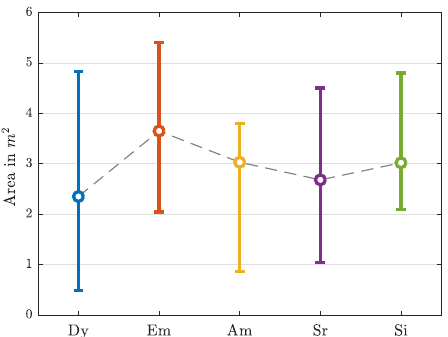
Figure 8. Median value and 95% confidence interval of the area under the standard deviation ellipse pooled for all beam directions ϕ S